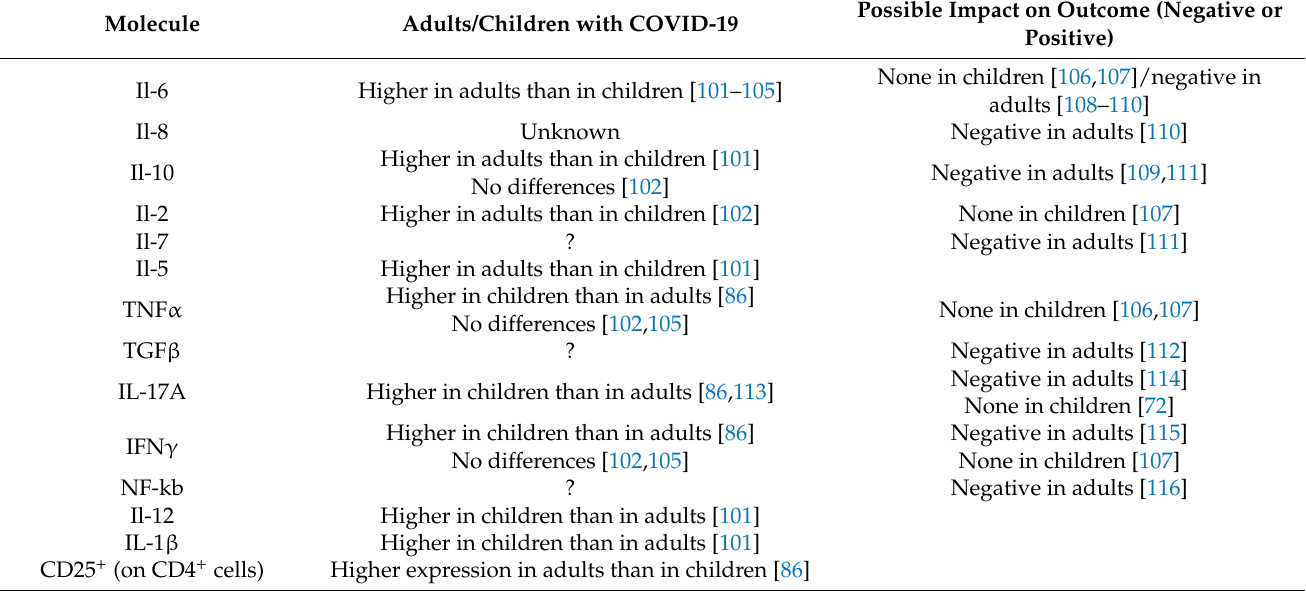
Table 2. Expression of immunological determinants related to disease outcome in COVID-19 in children and